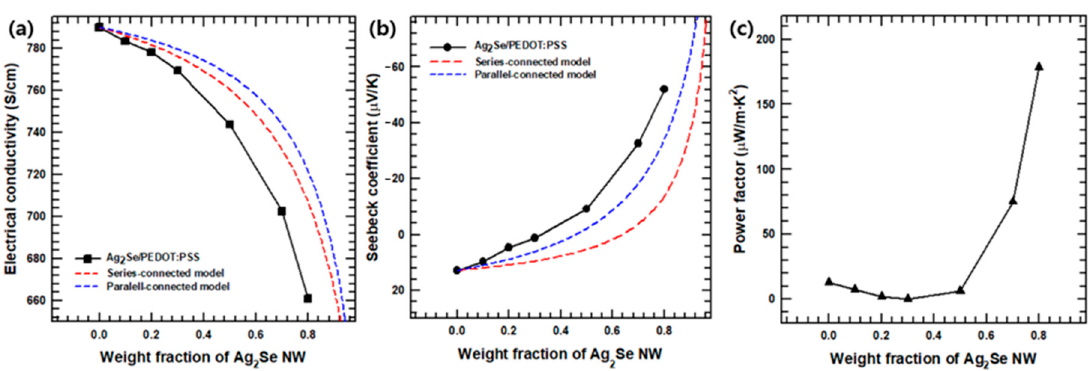
Figure 5. ( a ) Electrical conductivity, ( b ) Seebeck coefficient, and ( c ) power factor values of the Ag 2 Se NW / PEDOT:PSS composite films with two models (series and parallel connected models) as a function of the Ag 2 Se NW contents.